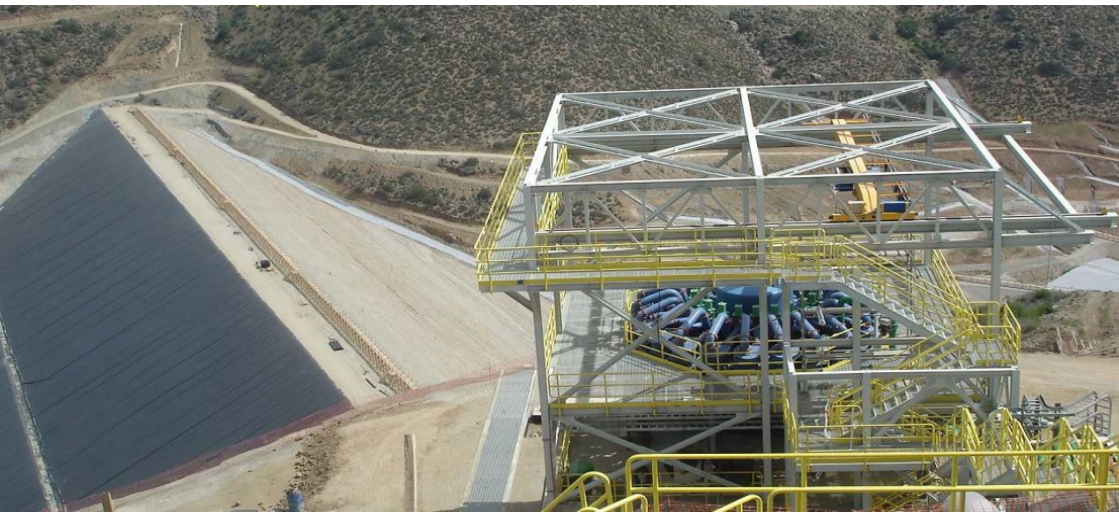
Figure 19. Panoramic view of TSF starter dam with geomembrane liner and mine tailings hydrocyclone station—TSF, Chile.